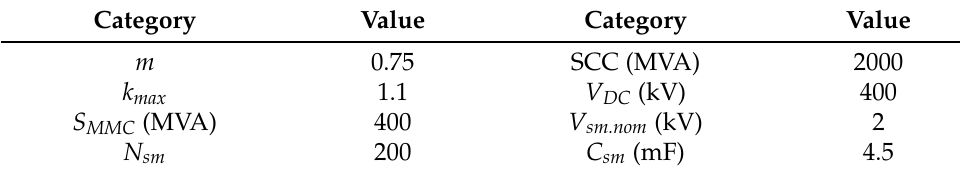
Figure 4. MPQC of MMC under different modulation index values. Table 1. MMC-HVDC specification for benchmarking Transbay